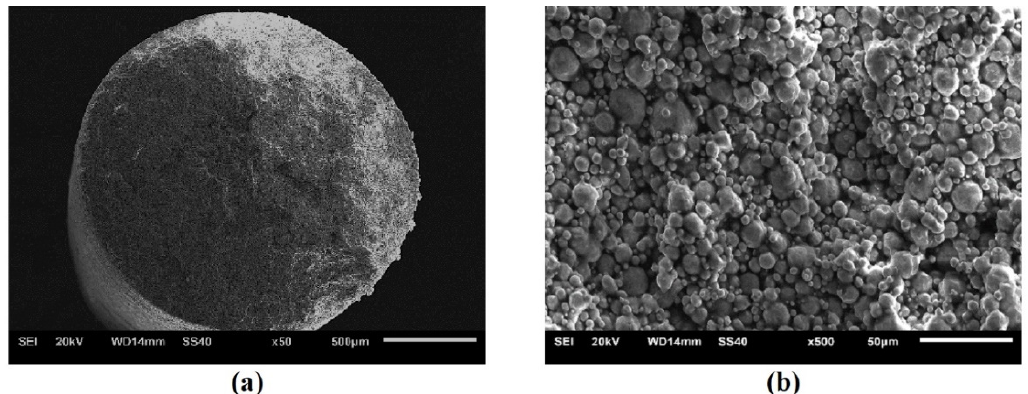
Figure 1. SEM micrographs of the copper filament cross section. ( a ) Details of the inner configuration of filament showing its cylindrical geometry. ( b ) Details of copper powder morphology and the binder system.